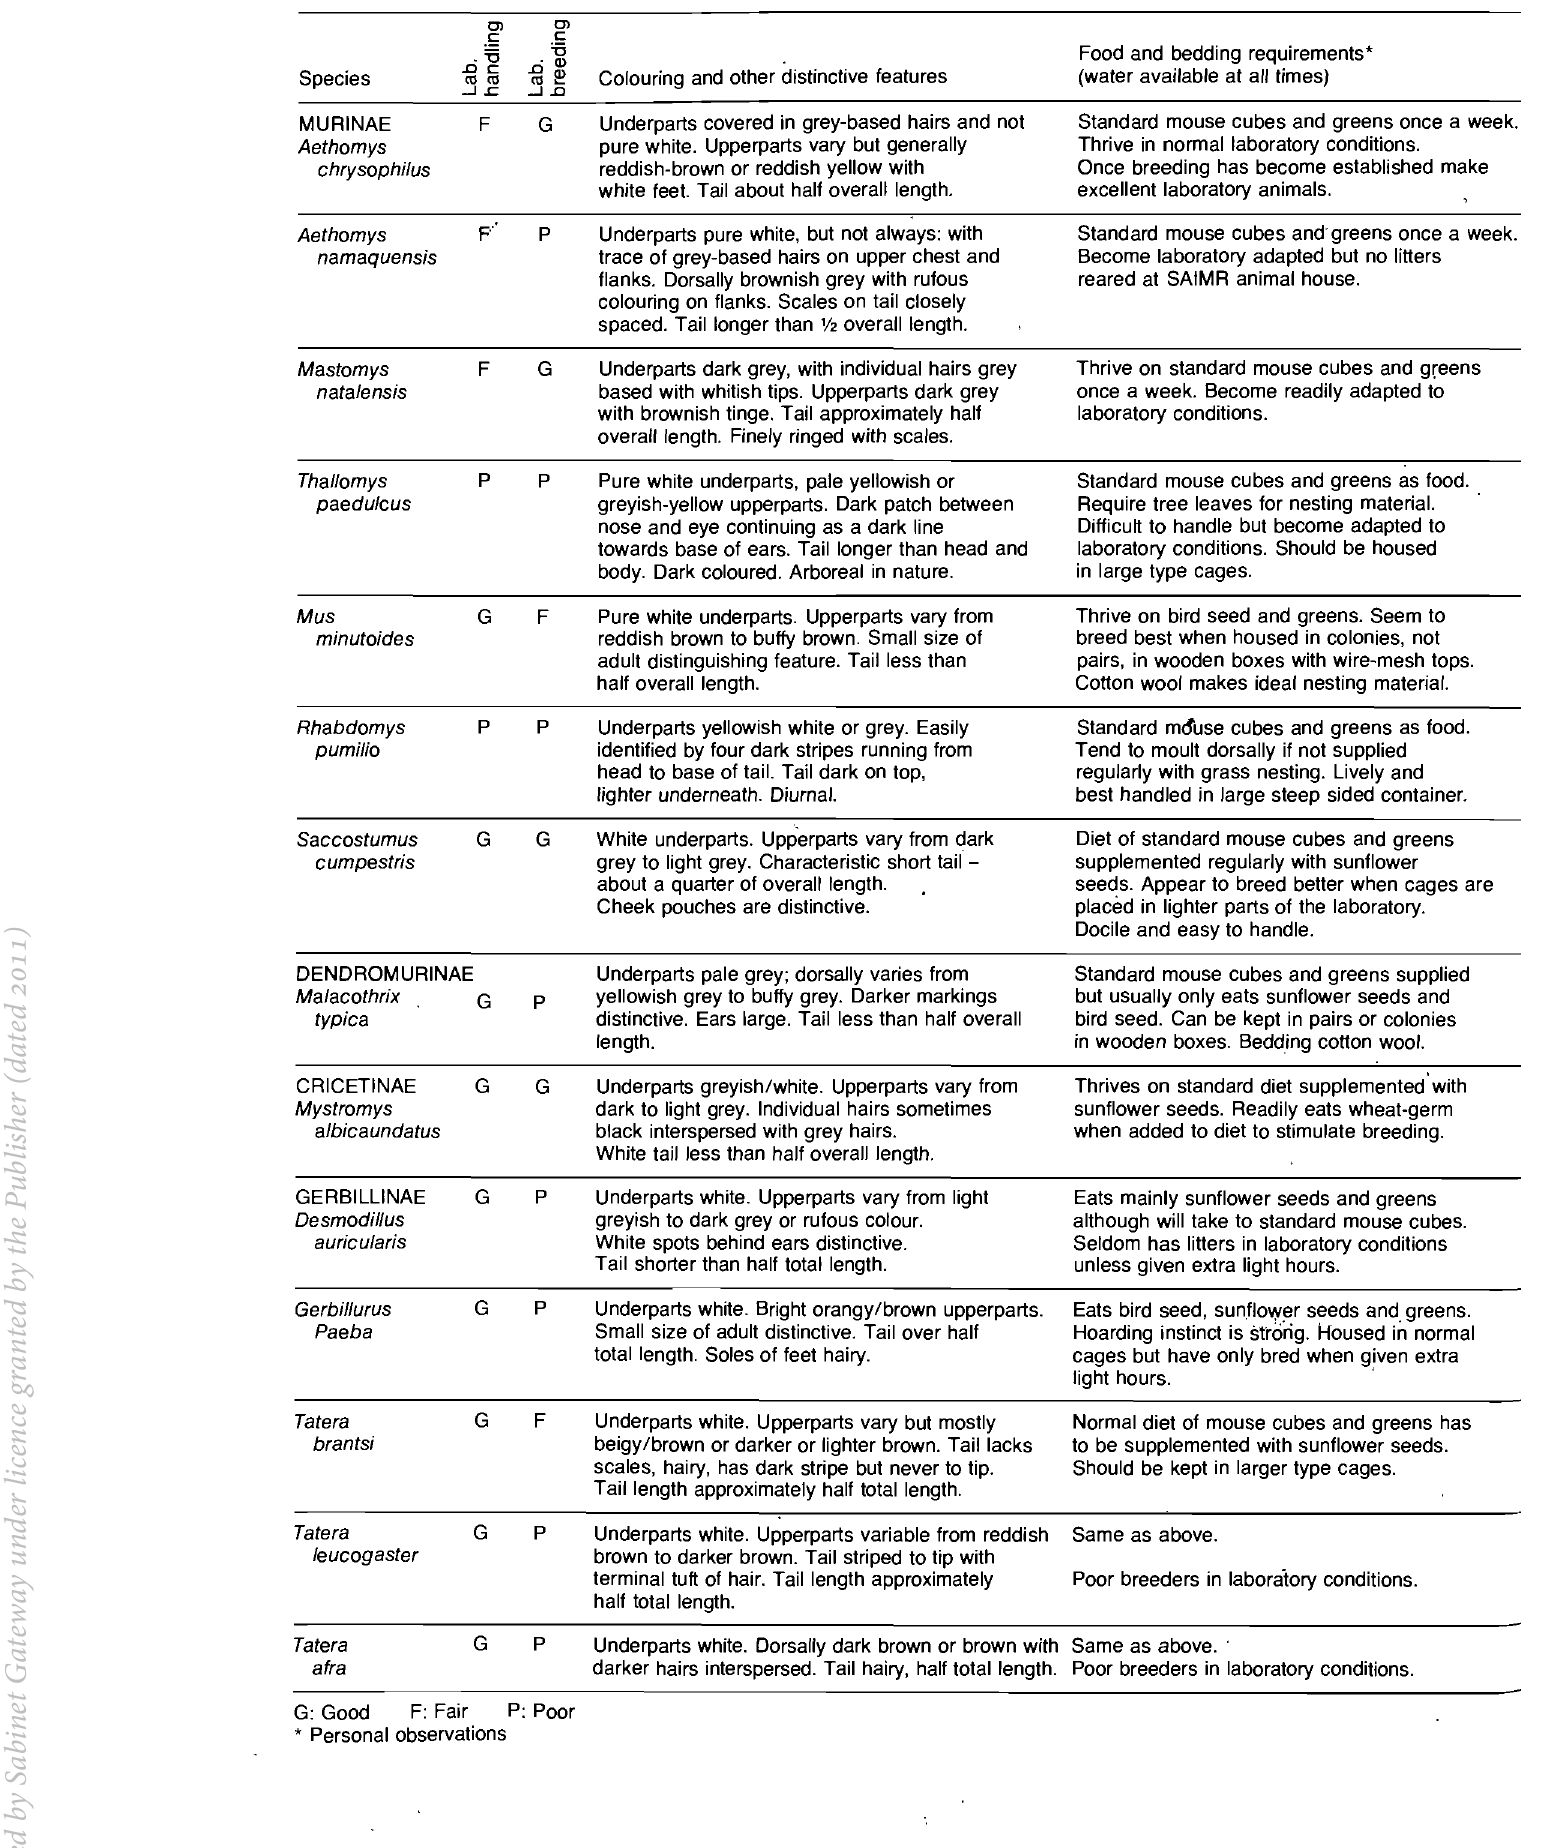
Table 1.: DISTINCTIVE FEATURES AND LABORATORY BREEDING NOTES ON 14 SPECIES OF